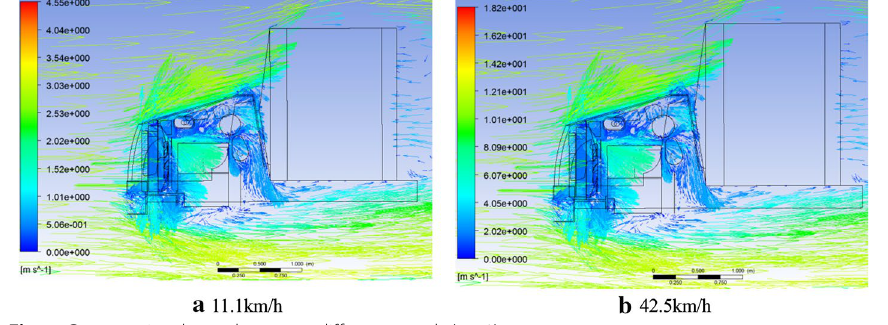
Fig. 4 Cross‑sectional speed vector at different speeds ( x